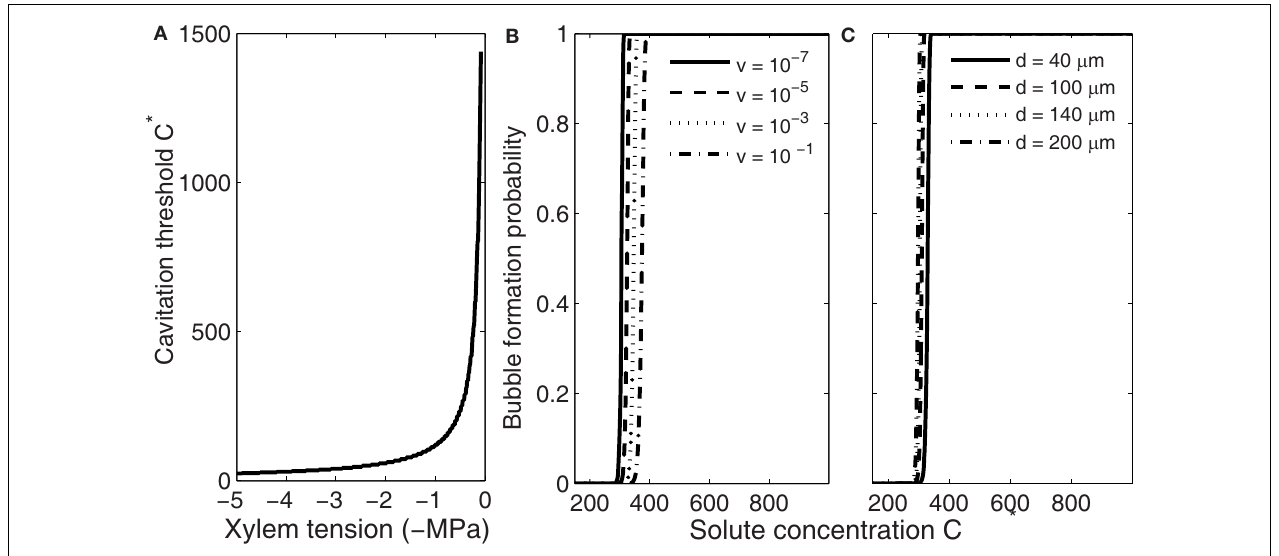
FIGURE 4 | Dependence of the threshold solute concentration for bubble formation via gas segregation on xylem water tension (A), freezing velocity (B), and conduit diameter (C). Xylem water tension determines the concentration at which bubble formation becomes likely, but whether that concentration is obtained during freezing depends on freezing velocity and